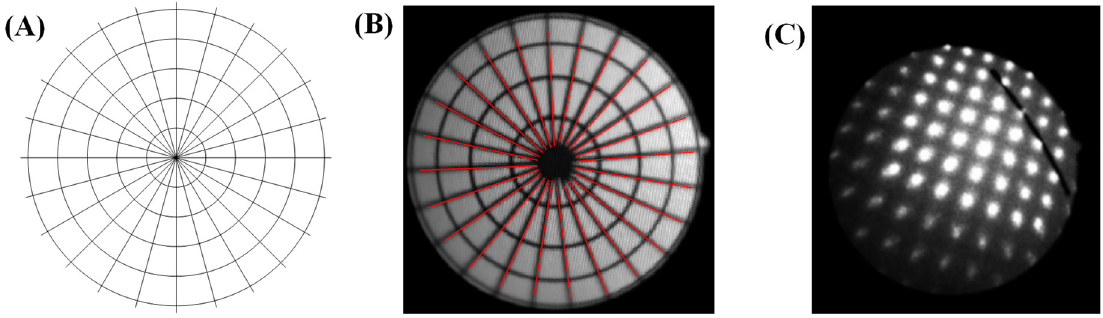
Figure 3 . The data for evaluation of central angle measurement: ( A ) the custom-designed grid, ( B ) segmented radial lines, and ( C ) an example of a line segment with the projected laser points.